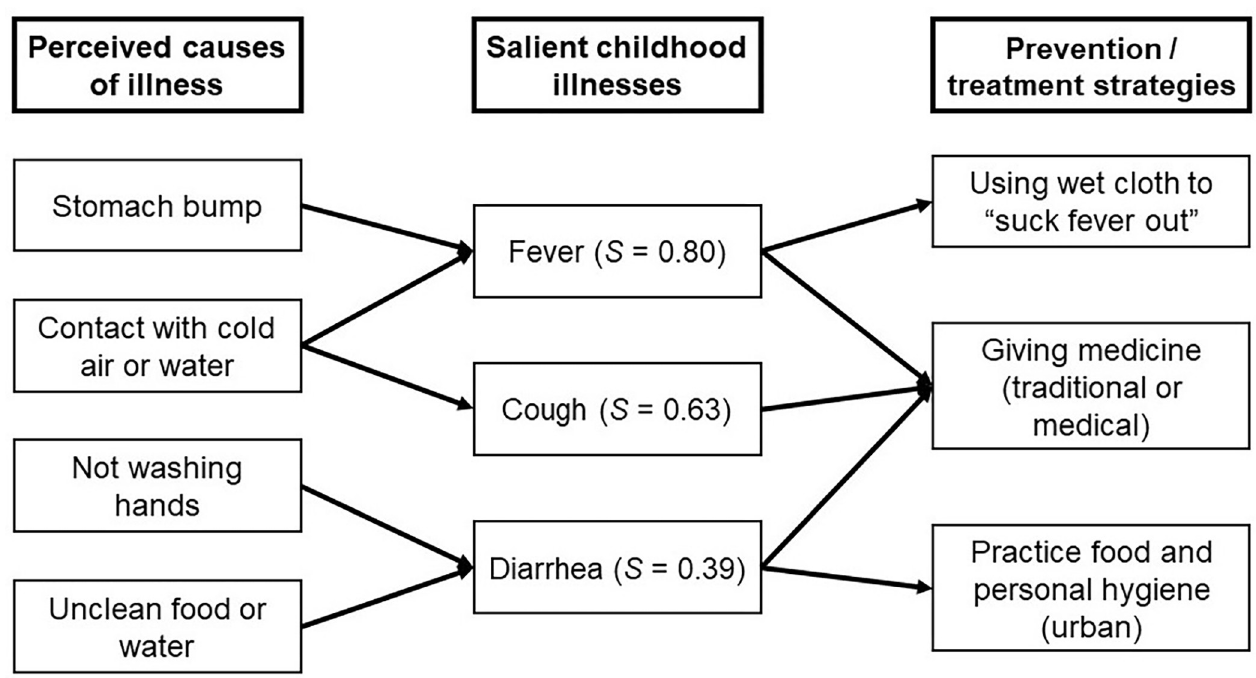
Fig 3. Ethnomedical model of salient infant and young child illnesses. Each perceived cause and prevention/treatment strategy represents a salient theme from interview or free list data.